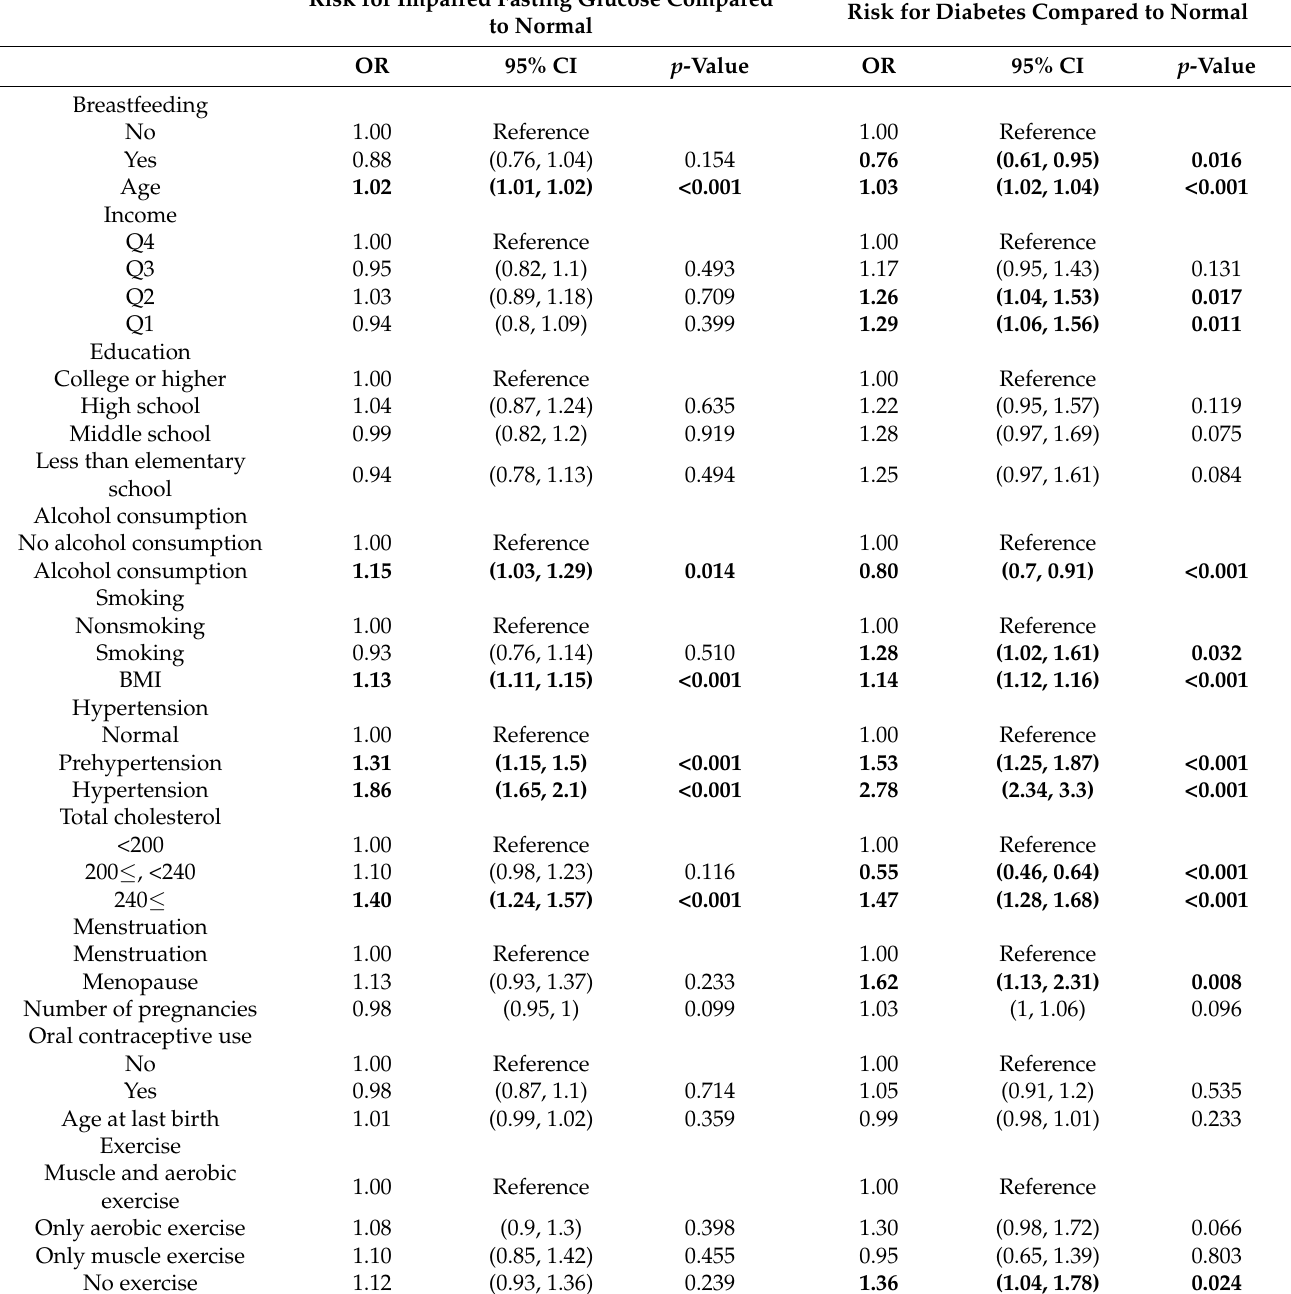
Table 3. Multivariate logistic regression analysis results of risk for impaired fasting glucose and diabetes according to breastfeeding experience. Risk for Impaired Fasting Glucose